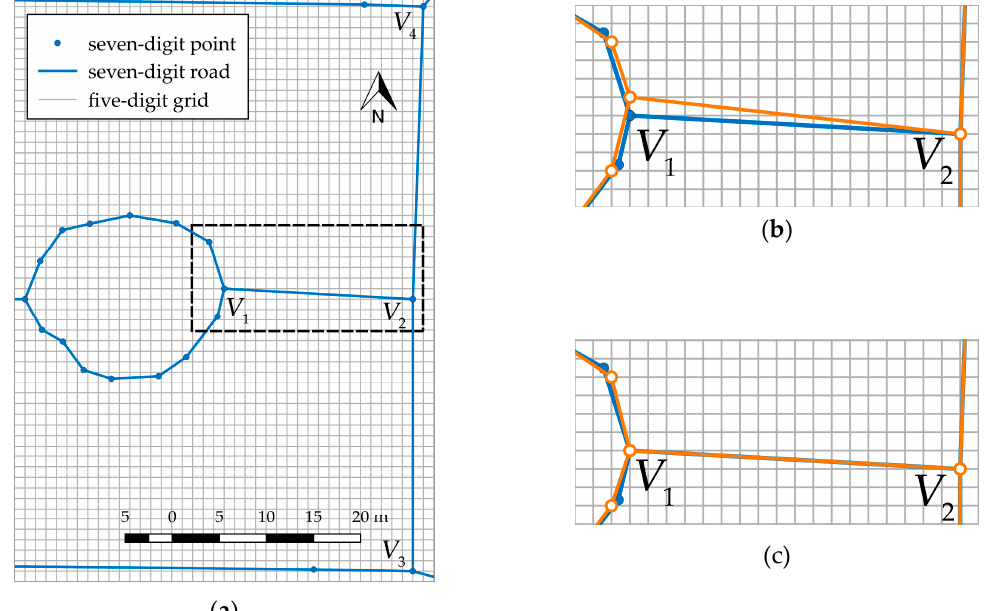
Figure 13. Maintenance of the spatial directional relationship at special nodes. The blue line represents the original road and the orange line represents the road with five-digit precision. ( a ) Original data with seven-digit precision, ( b ) adjustment from V 1 to V 2 , and ( c ) adjustment from V 2 to V 1 .